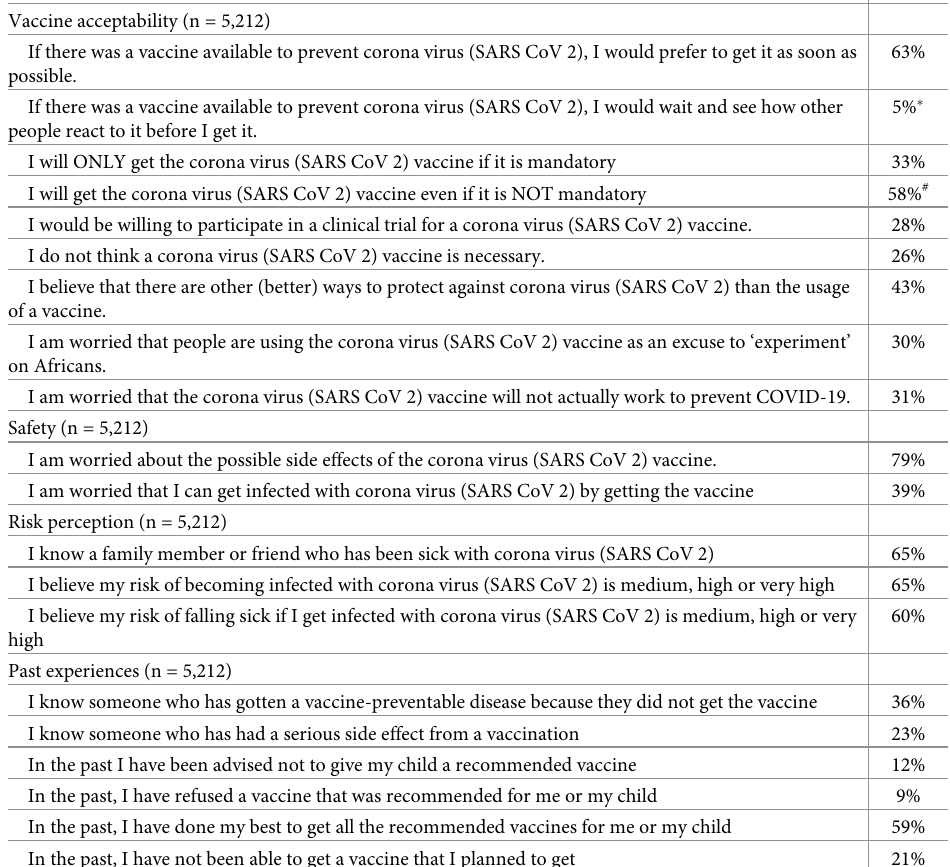
Table 1. Respondent’s attitudes and past experiences related to COVID-19 vaccination. Attitude Percent Vaccine acceptability (n =